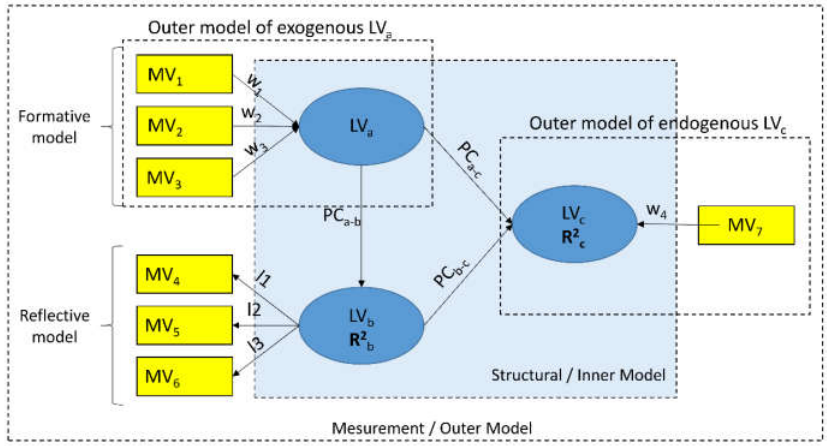
Figure 3. Example of a PLS-PM Design. Symbols: MV—measured variables; LV—latent variables; w—weights; l—loadings; PC—path coefficients; R2—coefficient of determination.